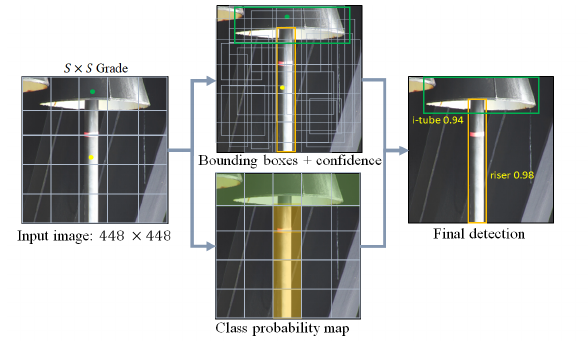
Figure 2. YOLO detection.